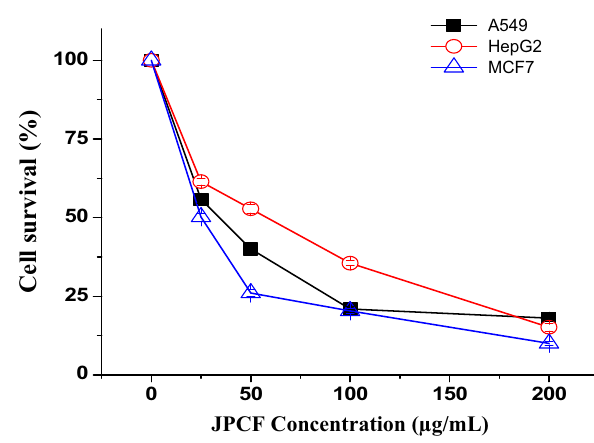
Figure 1: Antiproliferative e ff ect of JPCF on A549, HepG2, and MCF - 7. Cells were treated with J. phoenicea chloroform fraction ( JPCF ) at di ff erent concentrations for 48 h followed by the measurement of cell proliferation by MTT assay. Data represent as % of cell